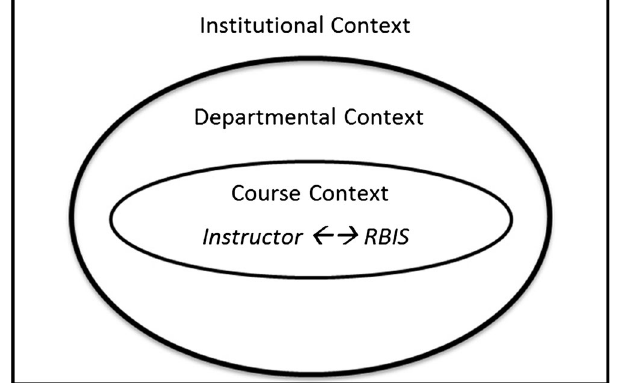
FIG. 1. Frames of context [37] that shape an instructor ’ s perceptions of an instructional